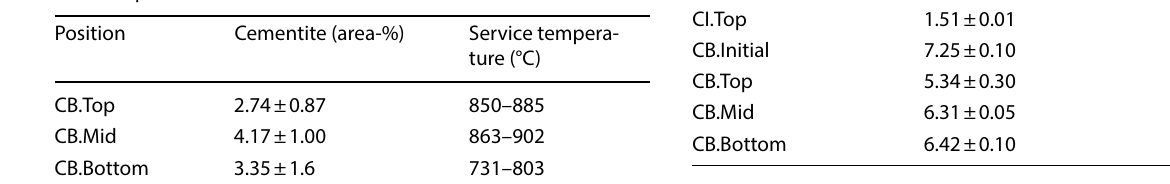
Table 3 Electrical conductivity of the initial state of the collector bar and cast iron and of the different positions after service Position Electrical conductivity (1/